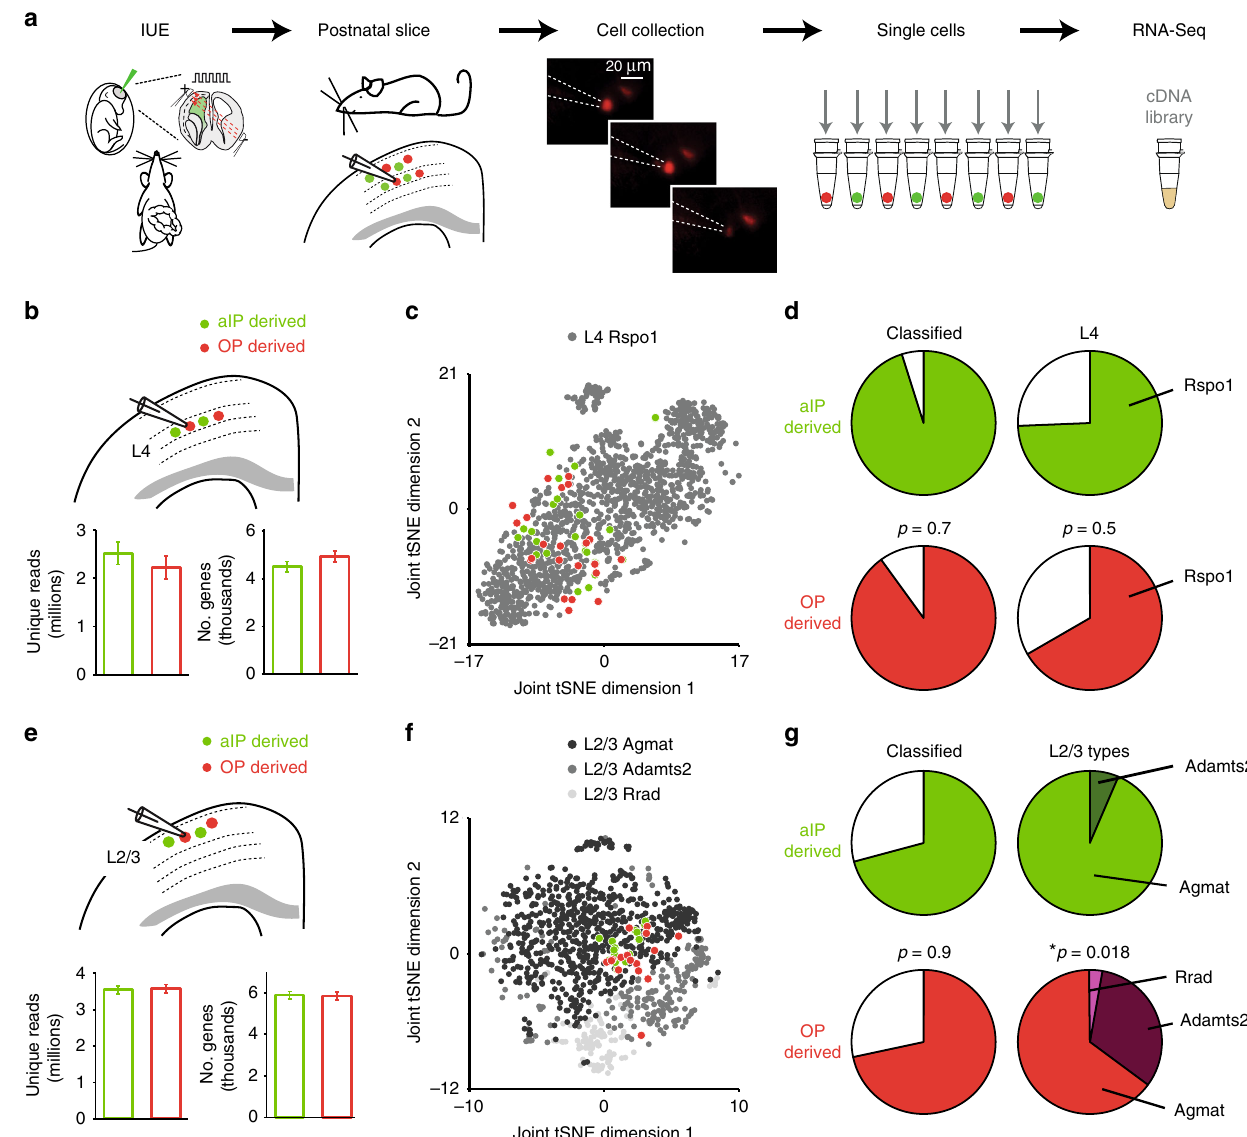
Fig. 2 aIPs contribute to speci fi c upper cortical layer neuron types. a Neighboring aIP-derived (GFP + ) and OP-derived (TdTomato + ) neurons were isolated alternately from S1 in acutely prepared postnatal brain slices. Batches of neurons from the same cortical layer were subjected to single-cell RNA-seq. b Within L4, aIP- and OP-derived neurons (top; n = 85 and 77 across P10 and P30, respectively) generated comparable numbers of unique reads (bottom; p